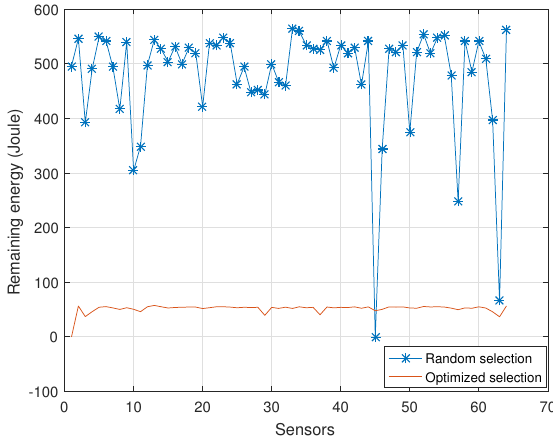
Figure 4. Remaining energy of each sensor node.